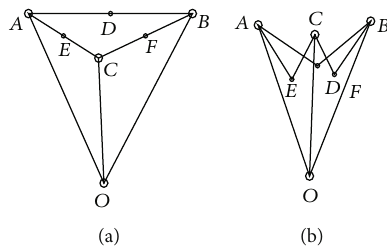
Figure 2: The principle of tetrahedral element expansion. (a) Folded state. (b) Expanded state.